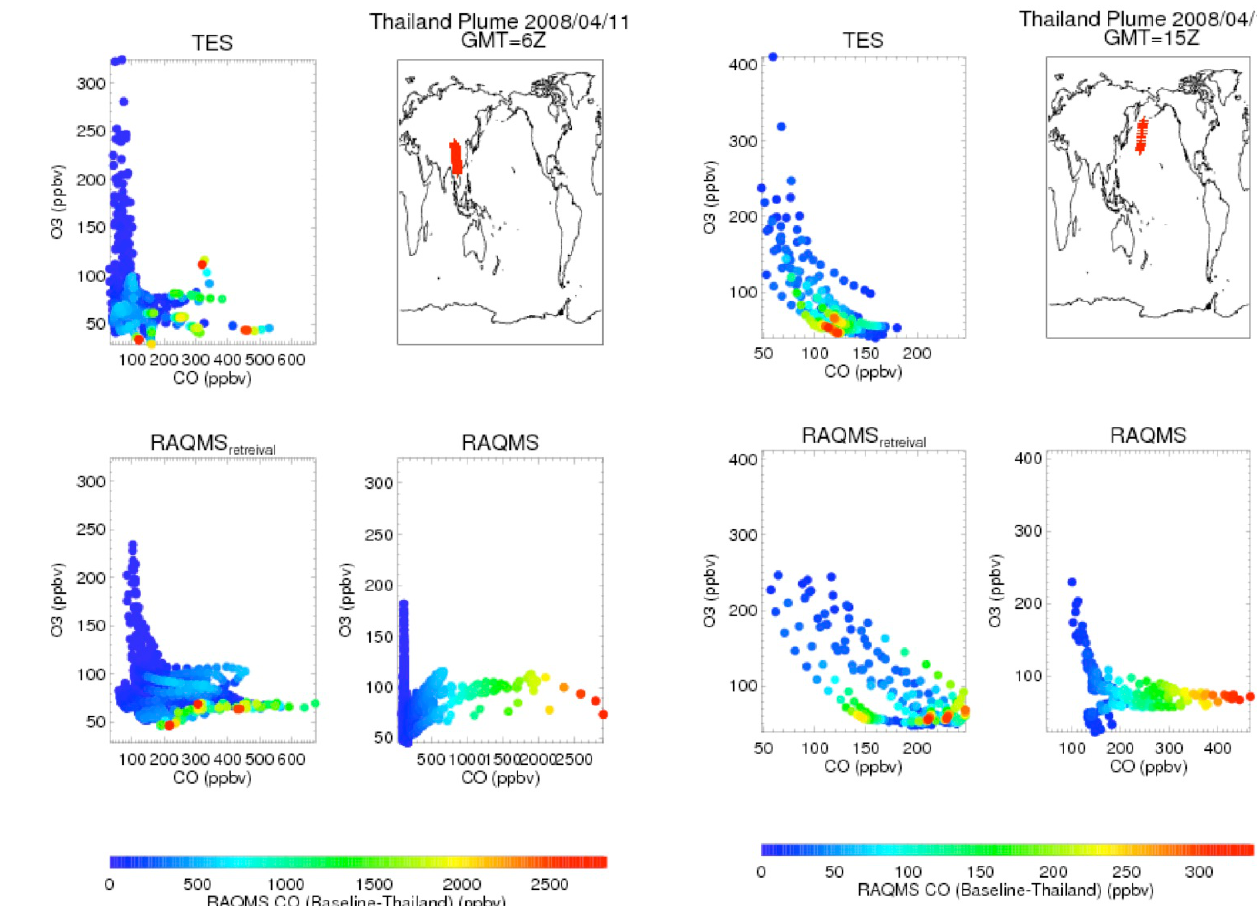
Figure 11b : Same as Figure 11a but downwind of Thailand plume